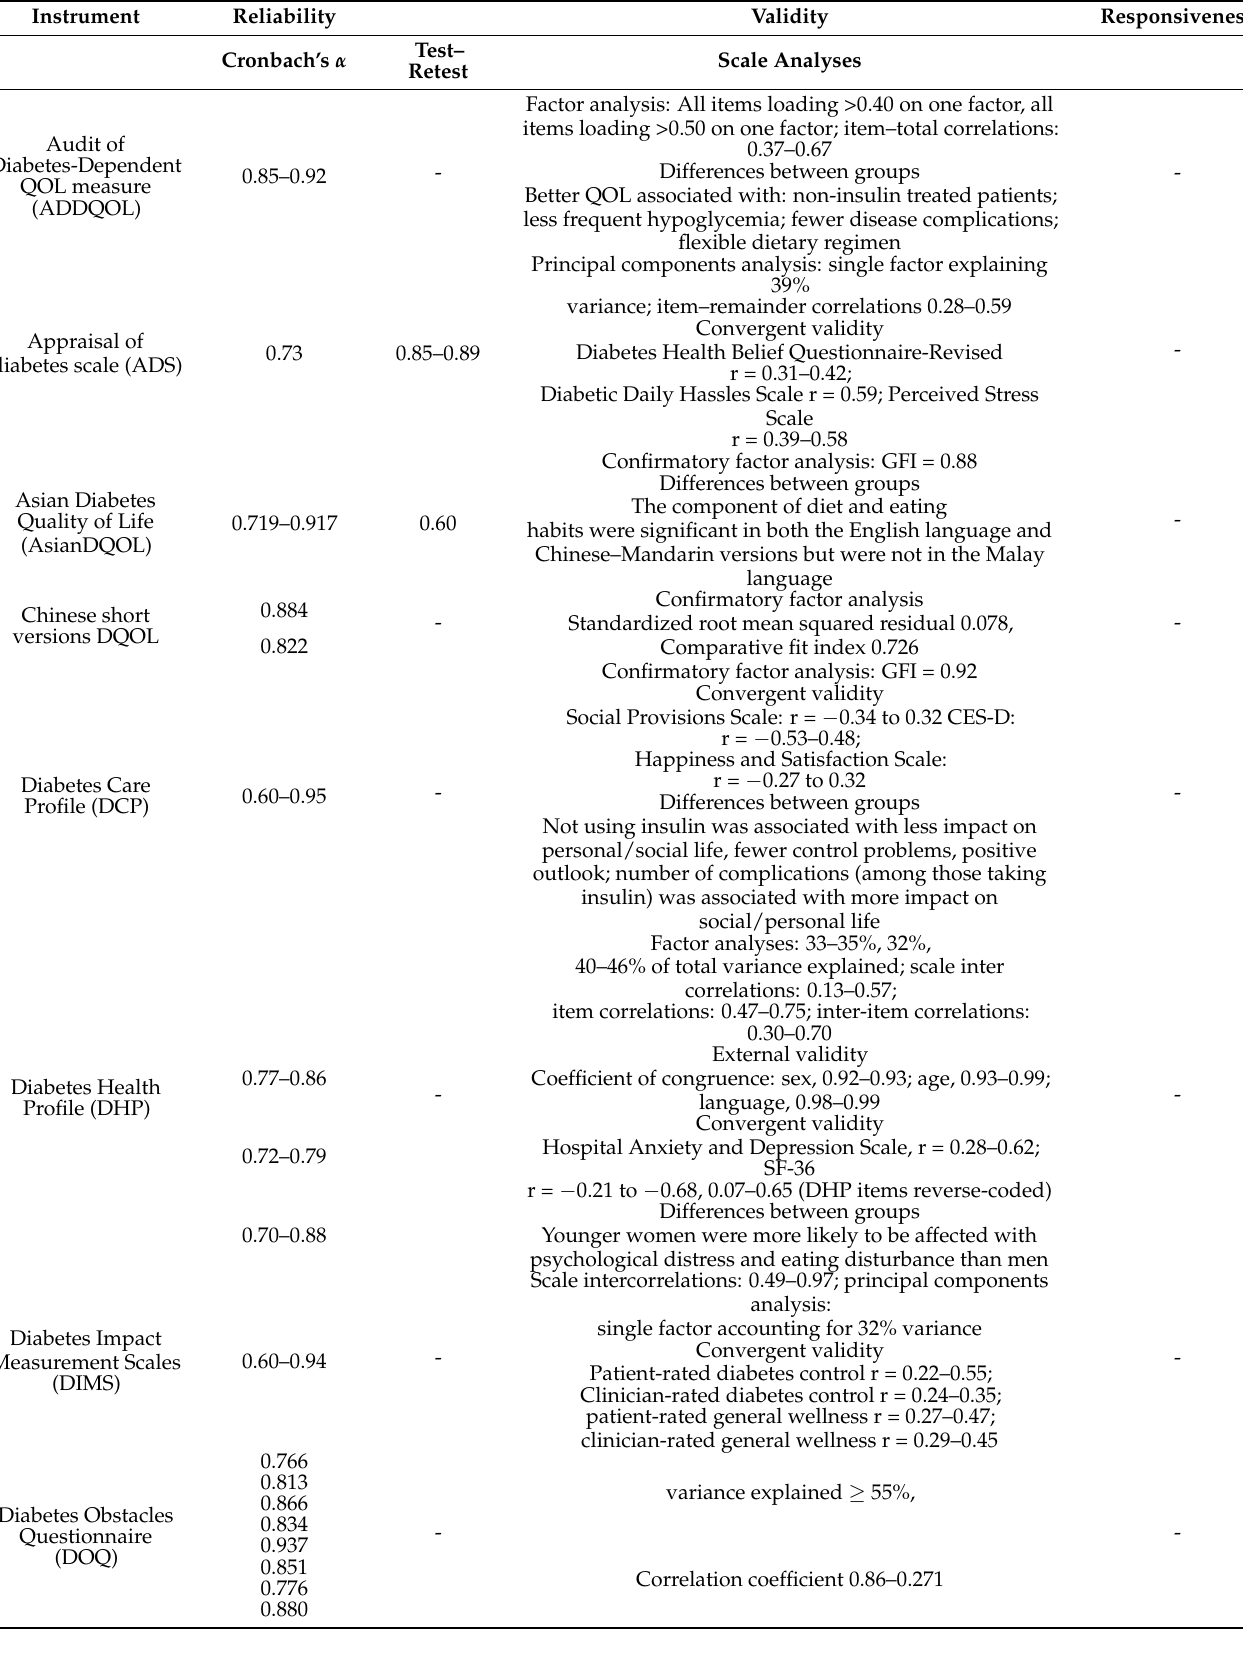
Table 2. Psychometric evaluation of diabetes specific health related QOL